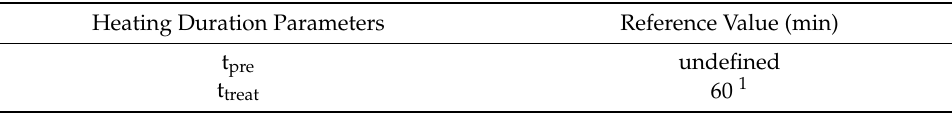
Table 3. Reference heating duration parameters for